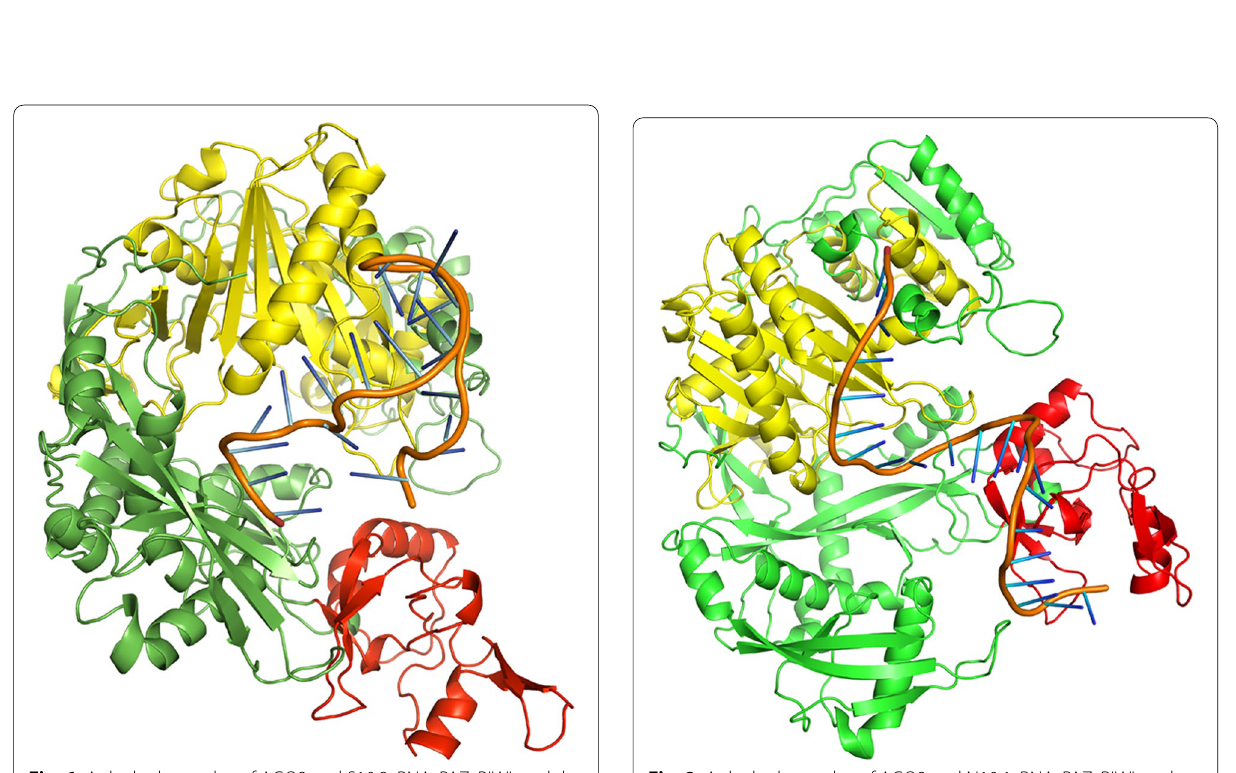
Fig. 8 A docked complex of AGO2 and N10.1. RNA, PAZ, PIWI, and the remaining regions are represented in orange, red, yellow, and green colors,